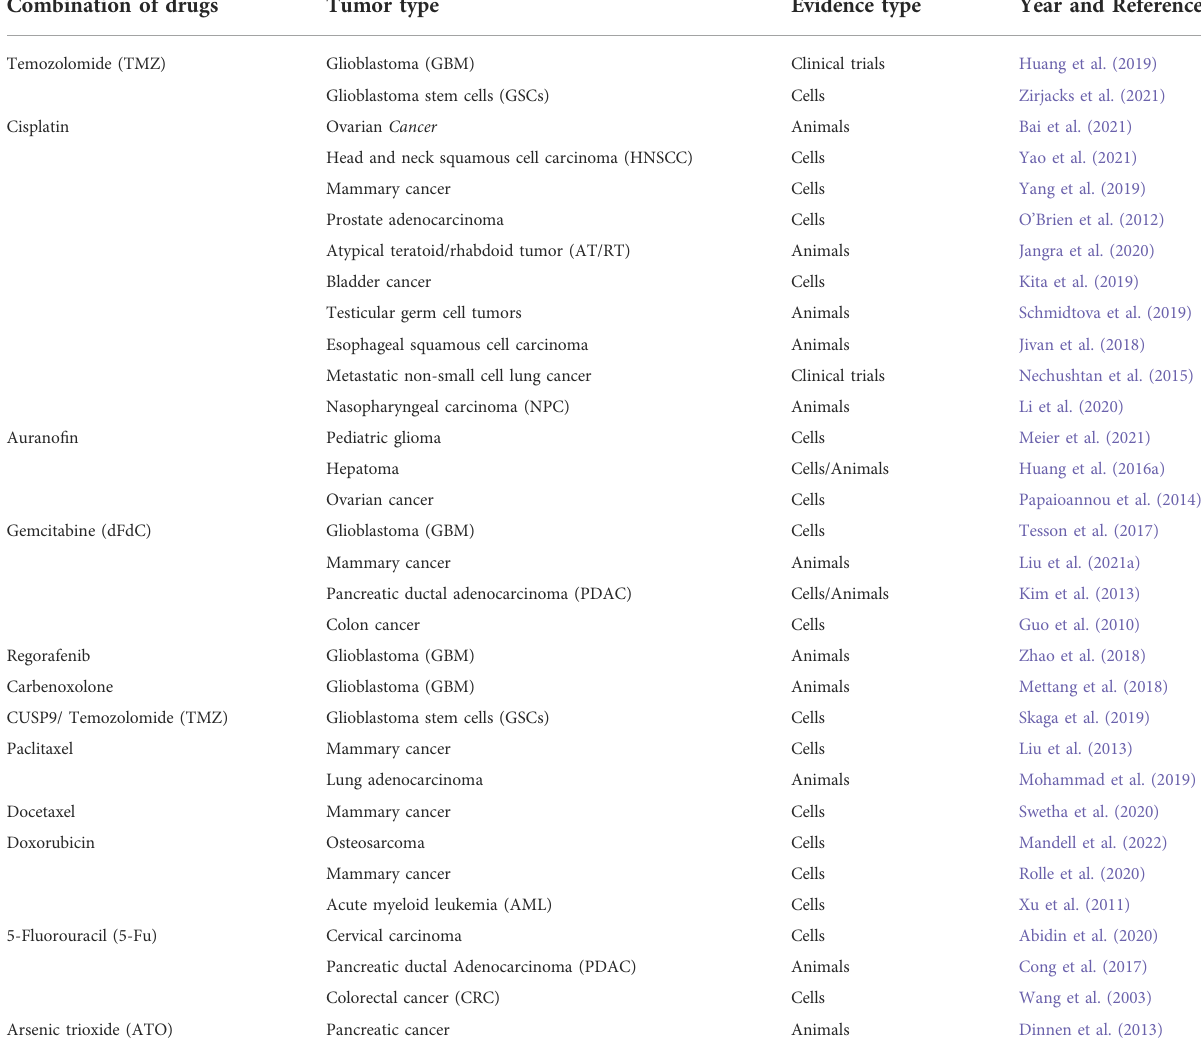
TABLE 2 The candidate chemicals used in combination with DSF for anticancer